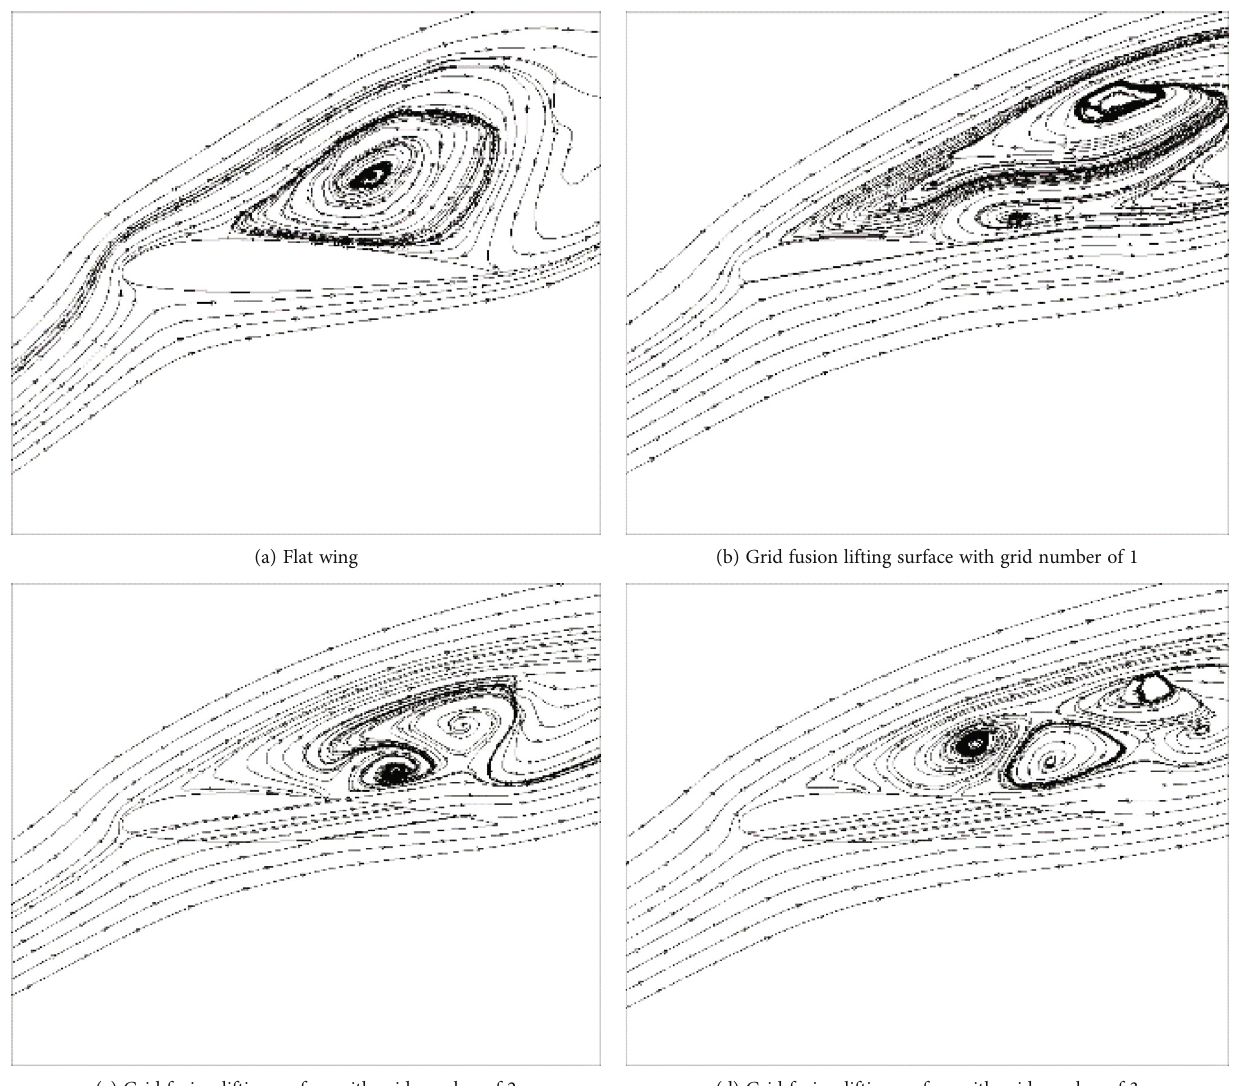
Figure 22: Fluid streamline diagrams of grid fusion lifting surface with di ff erent grid numbers ( Ma = 0 : 6 α = 28 ° z / b = 0 : 75